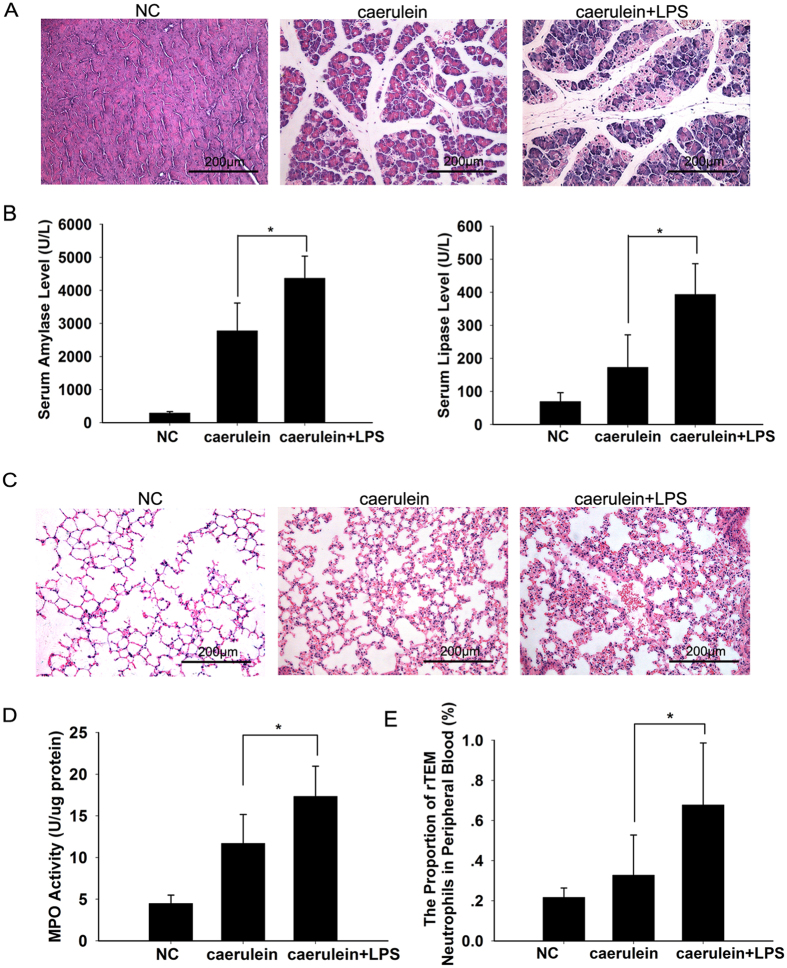
Pancreatic inflammation and lung injury were more apparent in caerulein and LPS-induced pancreatitis.(A) Representative micrographs of pancreatic tissue following caerulein and LPS-induced pancreatitis and single caerulein-induced pancreatitis are presented. (B) Serum concentration of amylase and lipase show pancreatic injury was more apparent in caerulein and LPS-induced pancreatitis (*p < 0.01). (C) Representative micrographs of lung tissue following caerulein and LPS-induced pancreatitis and single caerulein-induced pancreatitis are presented. (D) Myeloperoxidase (MPO) levels from lung tissue show lung injury was more apparent in caerulein and LPS-induced pancreatitis (*p < 0.05). (E) Significantly higher proportion of rTEM neutrophils in murine peripheral blood was observed in caerulein and LPS-induced pancreatitis (*p < 0.05). NC: normal control, n = 6 for each group. Original magnification ×200. Mice were sacrificed 12 h after the first caerulein injection.